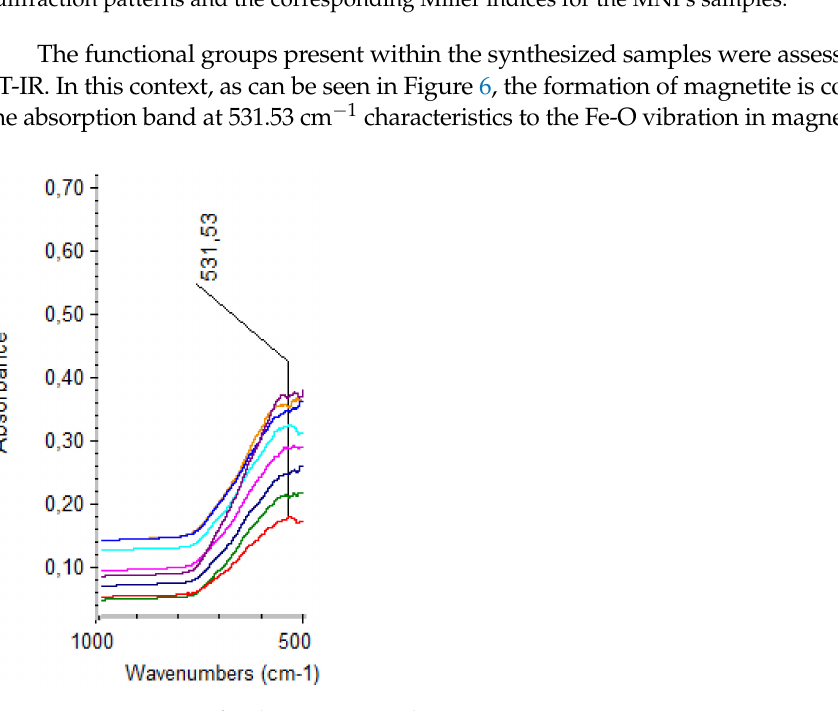
Figure 6. FT-IR spectra for the MNPs